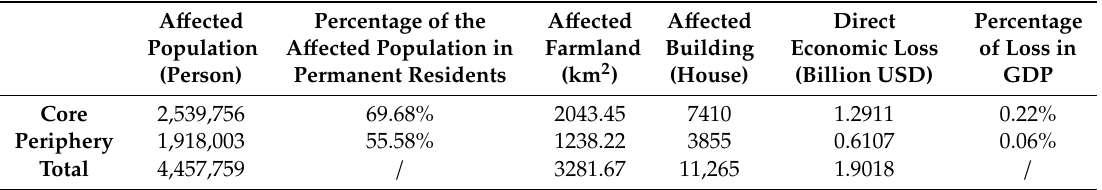
Table 2. Disaster damage by Typhoon Mangkhut in both core and periphery a ff ected areas. Notes: Excludes damages of Hong Kong and Macao. The exchange rate: 1 dollar = 6.7 yuan. Total permanent residents and GDP was